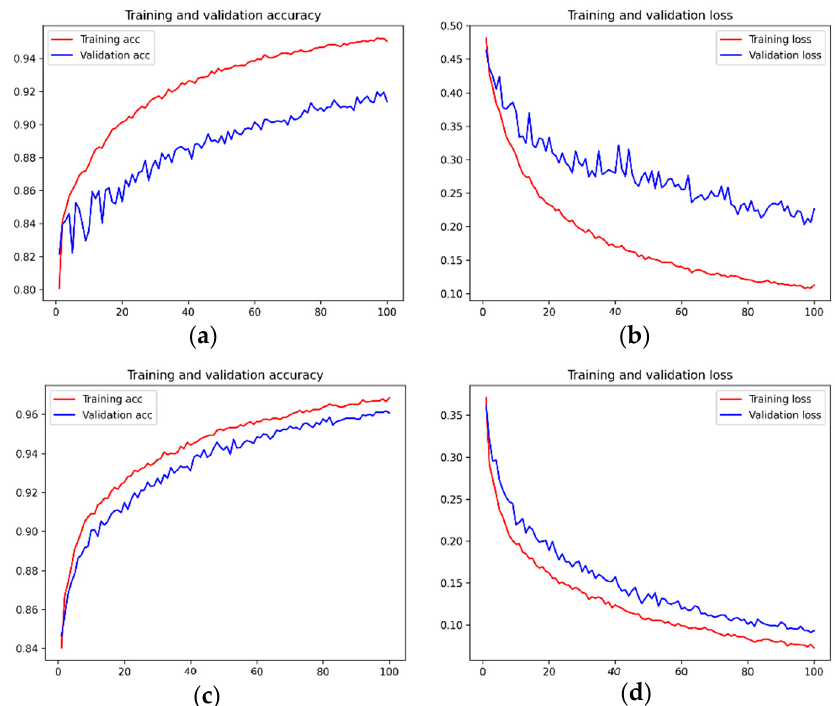
Figure 12. Accuracy and loss graphs for the training and validation datasets. ( a ) Pre-trained model’s training and validation datasets’ accuracy graph; ( b ) Pre-trained model’s training and validation datasets’ loss graph; ( c ) Transfer learning model’s training and validation datasets’ accuracy graph; ( d ) Transfer learning model’s training and validation datasets’ loss graph. The horizontal axis indicates the number of iterations and the vertical axis indicates the accuracy or loss value.